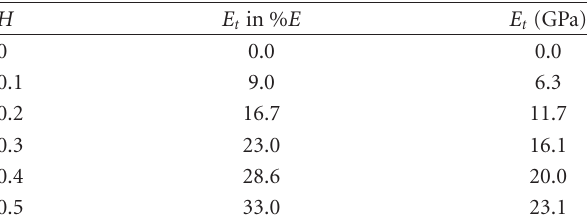
Table 1: Di ff erent H and E t values used for the study of strain hard- ening e ff